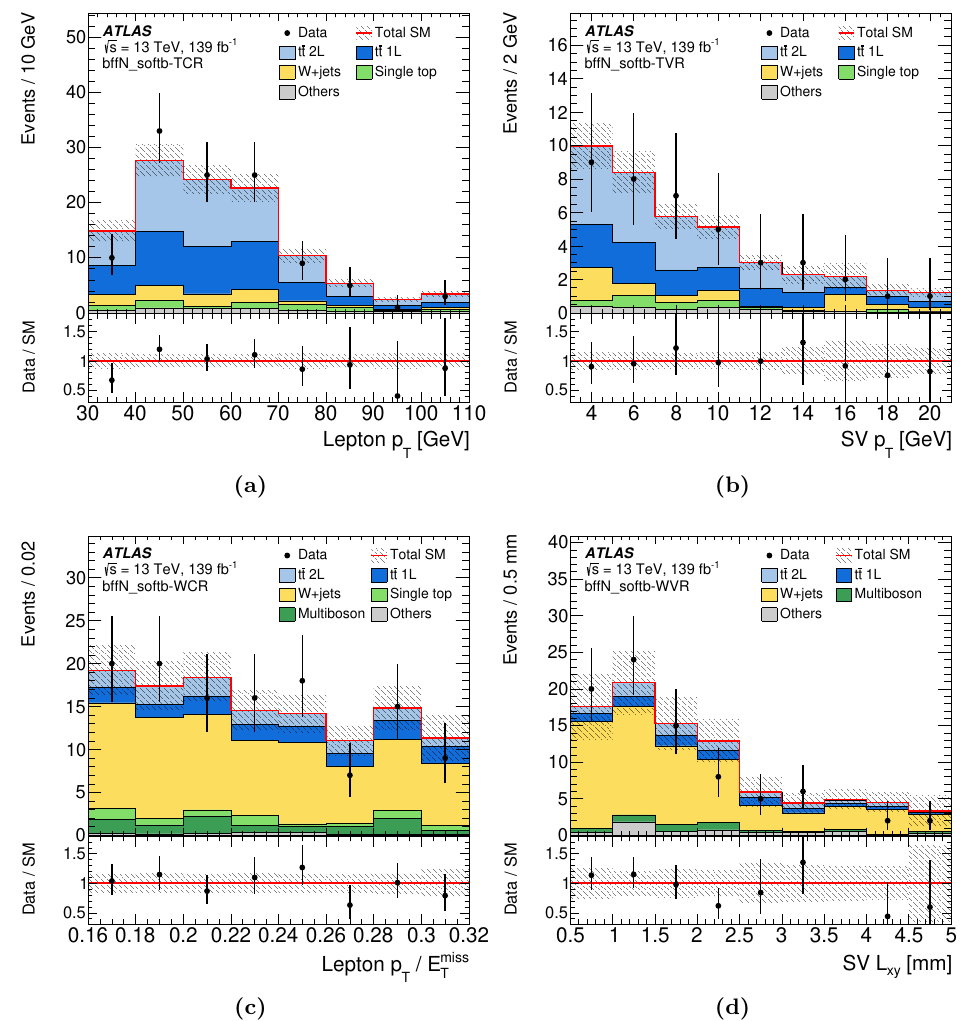
Figure 8. Selected kinematic distributions in bffN_softb CRs and VRs: (a) lepton p T in the TCR, (b) transverse component of the total track momentum attached to the secondary vertex, SV p T , in the TVR, (c) p ‘ /E miss in the WCR, (d) distance from the primary vertex to the secondary T T vertex in the transverse plane, SV L xy , in the WVR. The distributions shown are post-fit, i.e. each background is scaled by a normalisation factor obtained from a background-only likelihood fit to the CRs (see table 14). The hatched area around the total SM prediction and the hatched band in the Data/SM ratio include all statistical and systematic uncertainties. The last (first) bin contains overflows